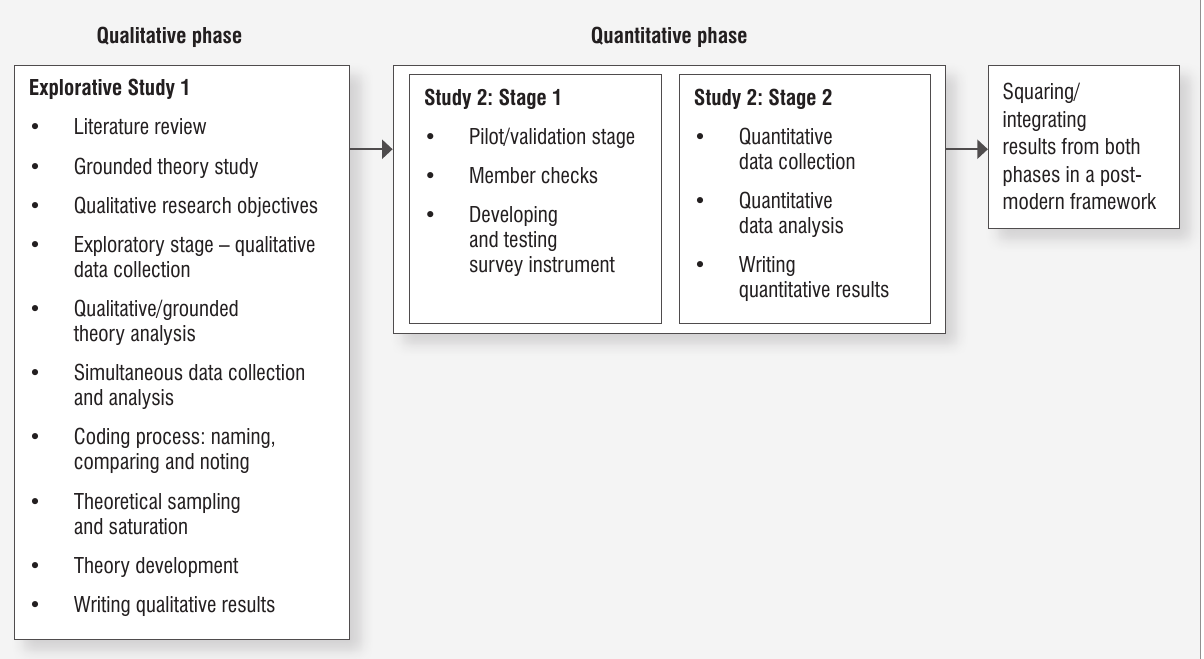
Figure 1: Research design: stages of